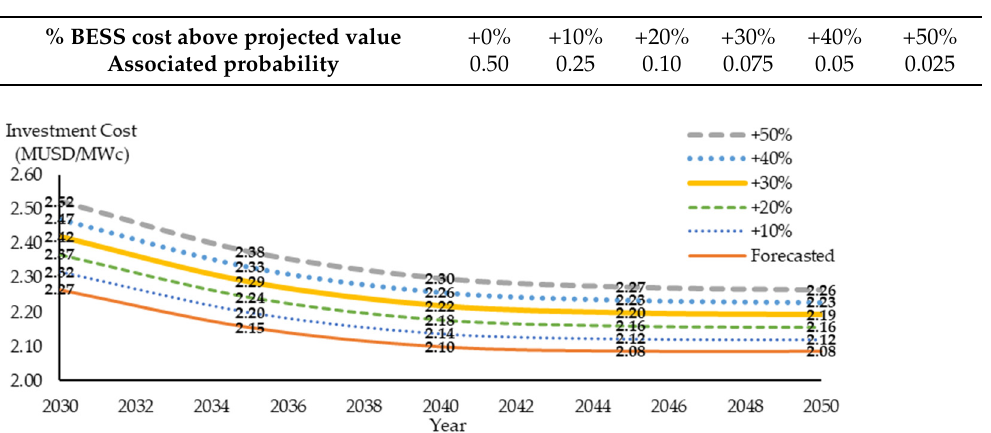
Table 1. Uncertainty of projected BESS cost.